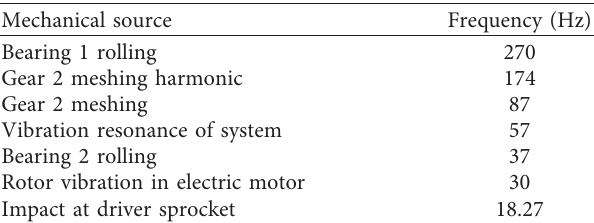
Figure 7: Time-frequency analysis for the vibration by applying CWTto raw vibration signals. (a) Fault no.1. (b) Fault no. 2. (c) Fault no. 3. (d) Fault no. 4. (e) Fault no. 5. (f) Fault no. 6. (g) Fault no. 7. (h) Fault no. 8. (i) Normal. Table 2: Signal analysis for vibration data measured by a